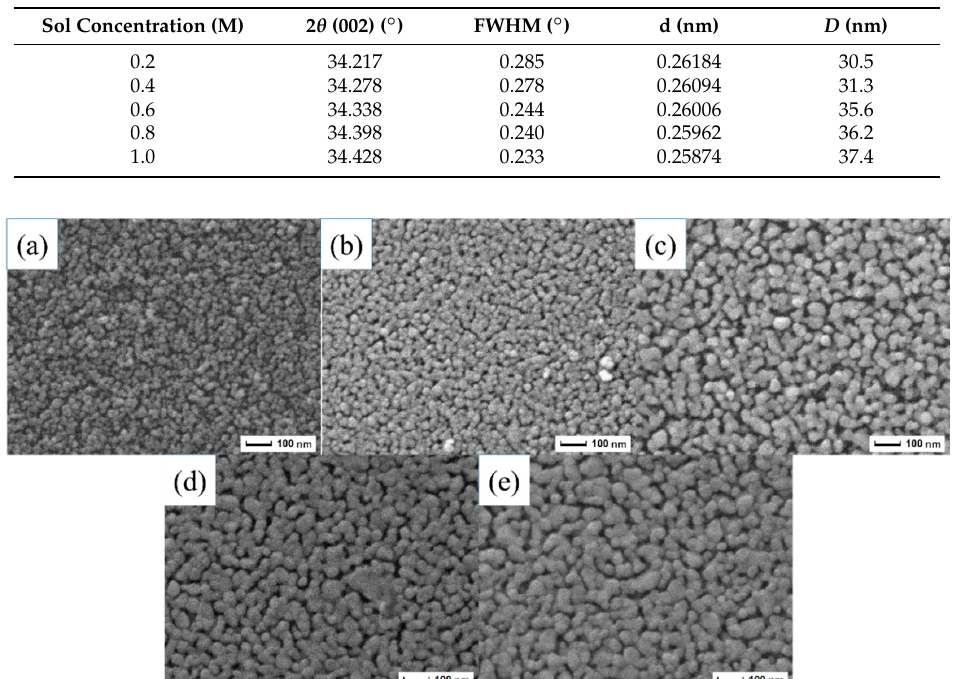
Figure 6. Variation of the grain size and the full width at half maximum intensity (FWHM) of the ZnO films according to the sol concentration. Table 1. The structural parameters of the (0 0 2) plane of the ZnO porous thin films deposited at different sol concentrations (2 θ : peak position, d: interplanar spacing, and D : grain size.).